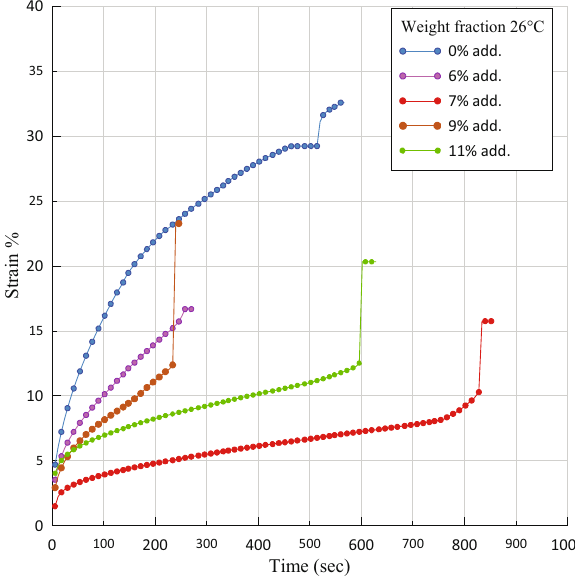
Figure 7: Strain versus time for UP/PS reinforced by di ff erent fi sh fl akes weight fractions at 26°C.